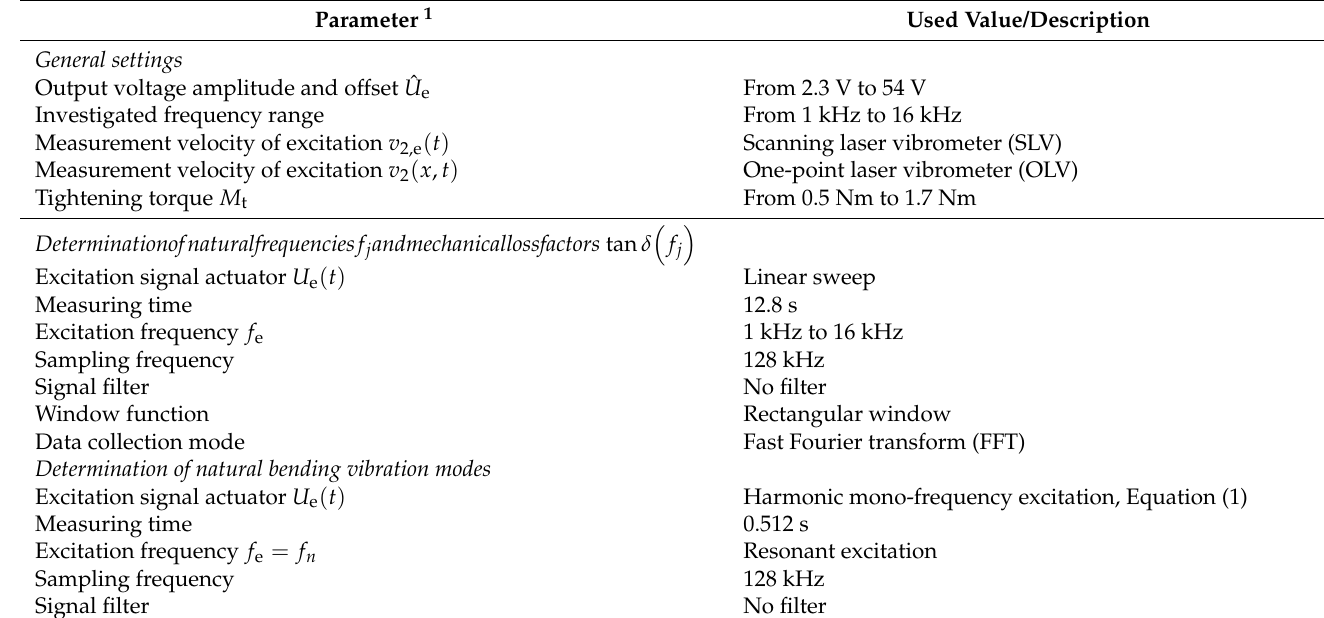
Table 1. Experimental parameters for vibration